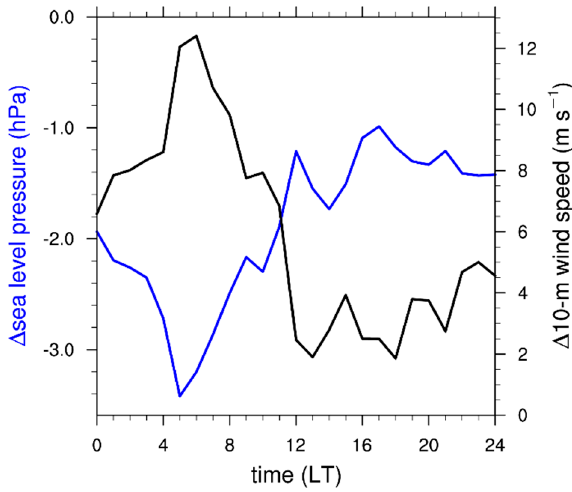
Figure 10. Time series of the sea-level pressure (blue line) and the 10-m wind speed (black line) differences between the gap inside and the gap exit. The values of the gap inside and the gap exit are averaged over points 1–12 and points 13–14, respectively.